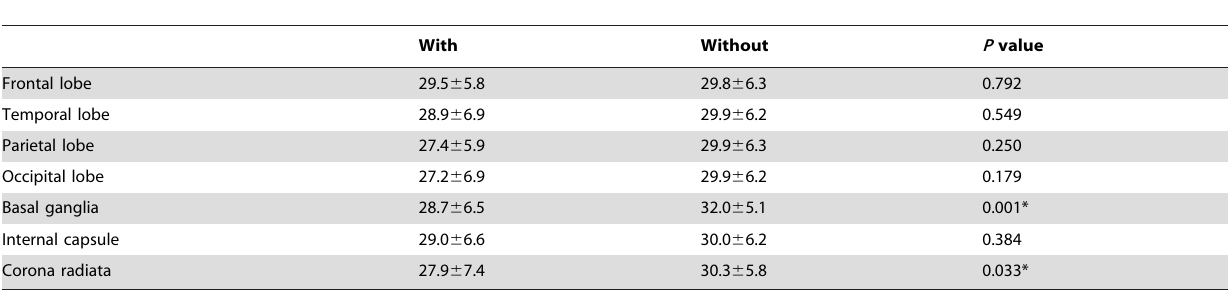
Table 2. Comparison of MDRS I/P score between patients with and without the infarction lesion stratified by location.